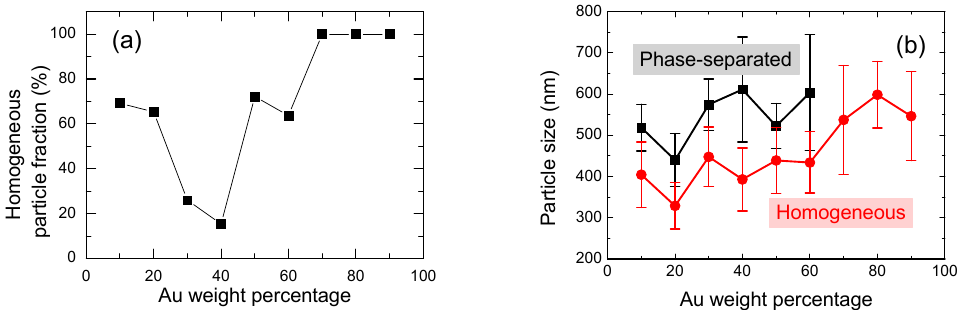
Figure 4. ( a ) Homogeneous particle fraction as a function of Au weight percentage. ( b ) Average particle size of phase-separated and homogeneous submicrometre particles as a function of Au weight percentage.